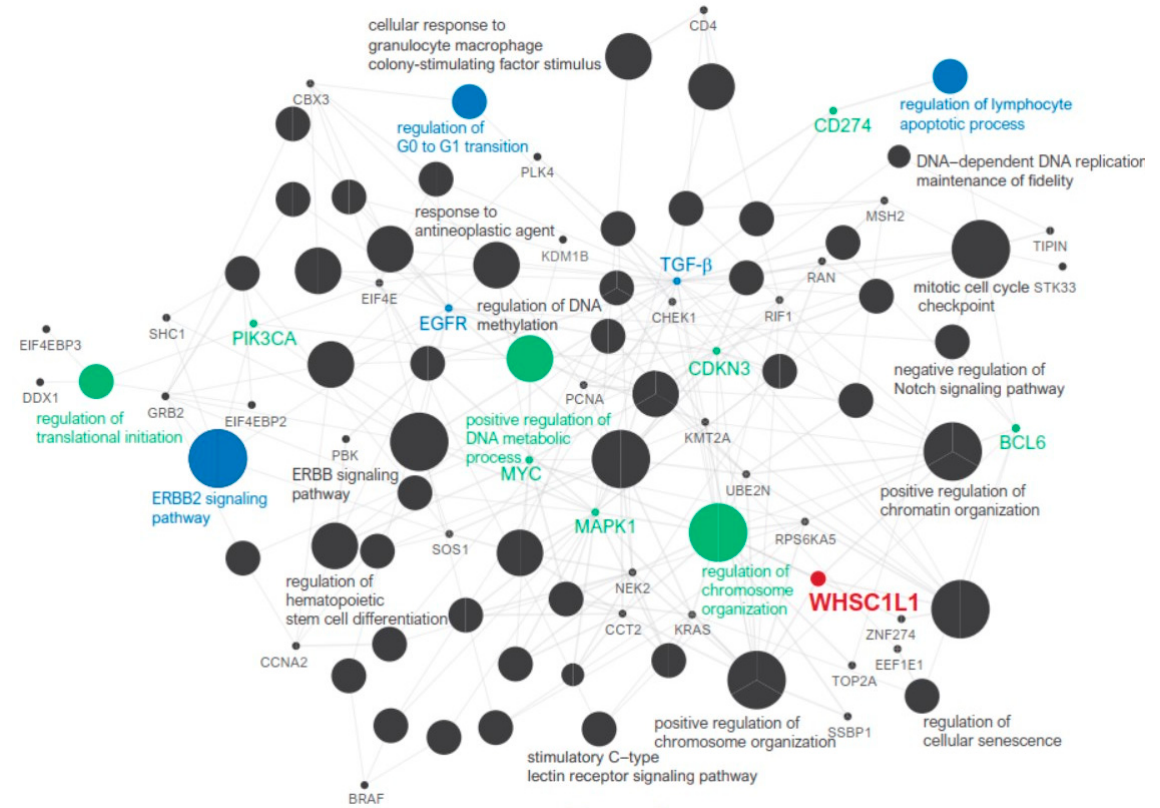
Figure 3. Functionally grouped networks are linked to their biological function, and only the most significant term of the group is labeled.